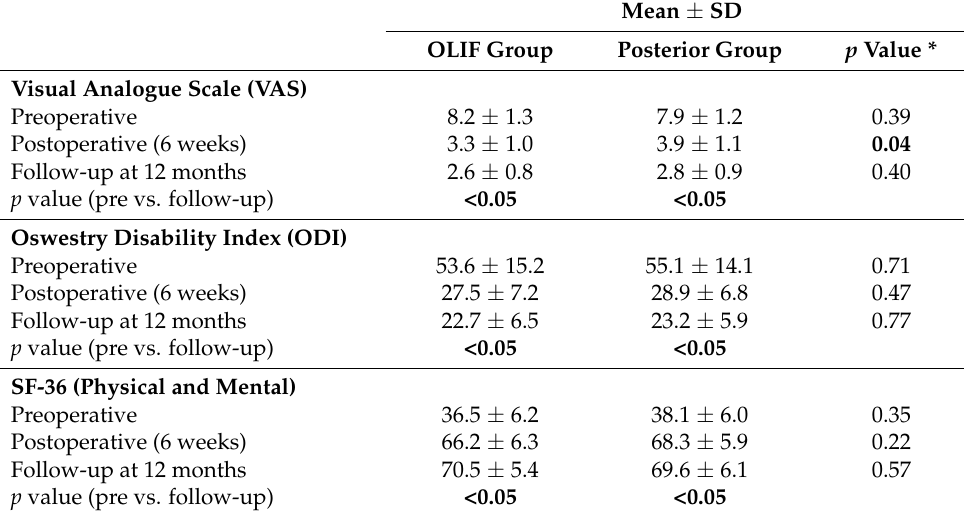
Table 3. Clinical